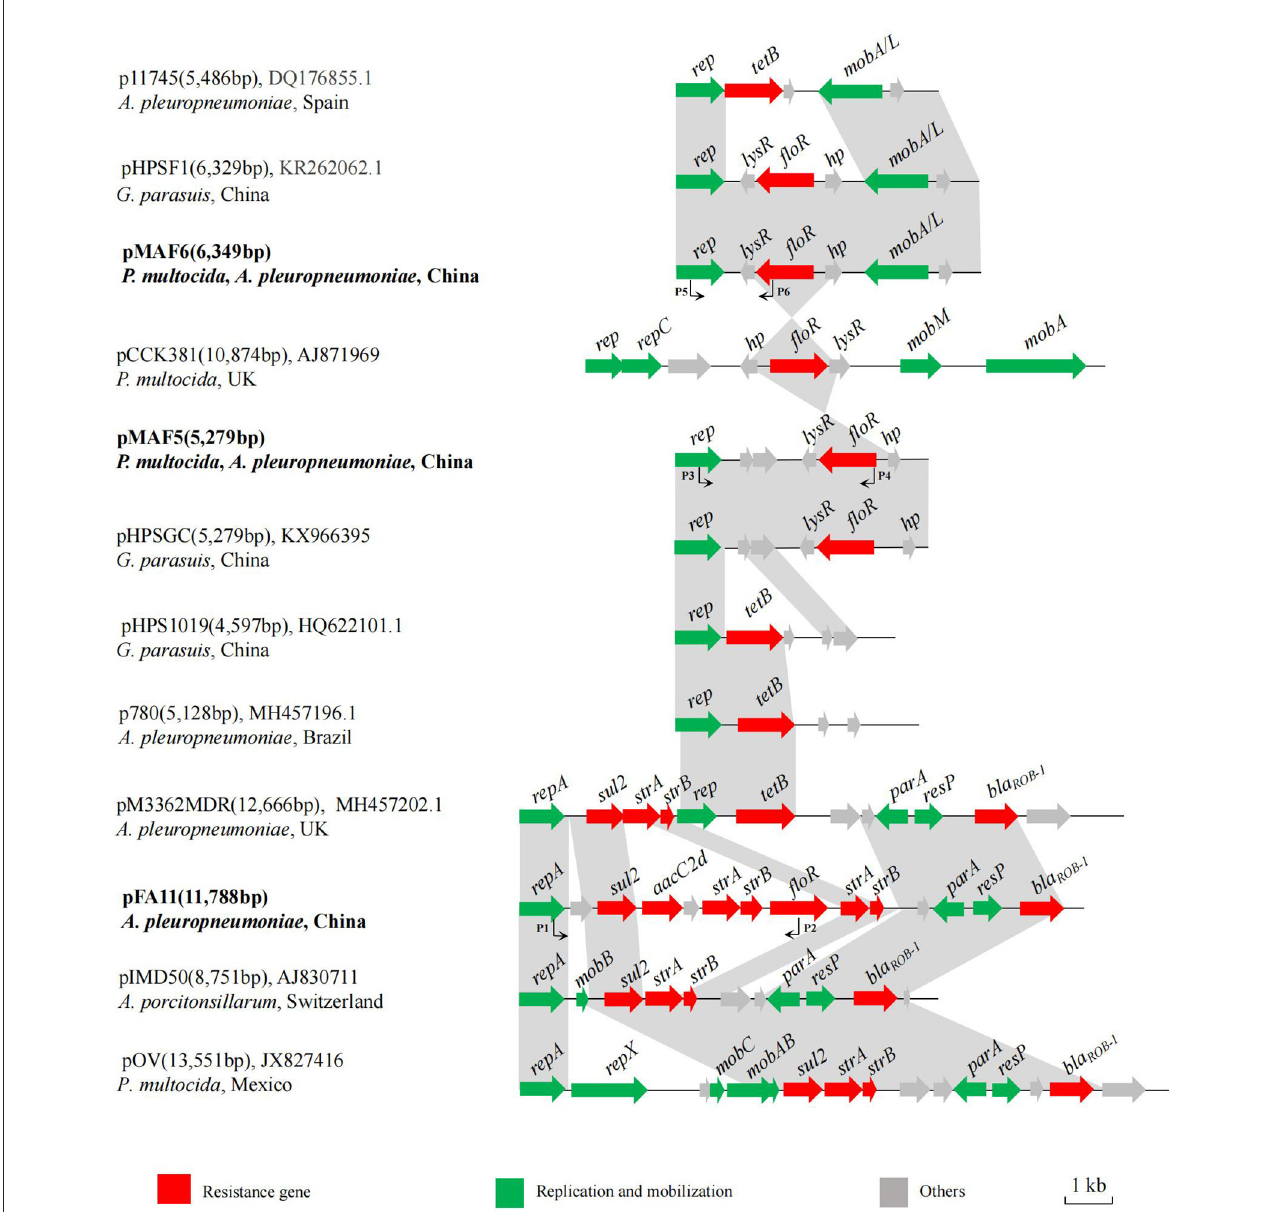
FIGURE2 Schematic comparison of the floR -carrying plasmids pFA11, pMAF5, and pMAF6 with related plasmids in Genbank. Arrows represented the positions, orientations and relative sizes of the genes. The regions with ≥ 98% homology between these plasmids are marked by gray shading. The plasmid name, size, GenBank accession number, host bacteria and country of origin are given on the left of each plasmid map.